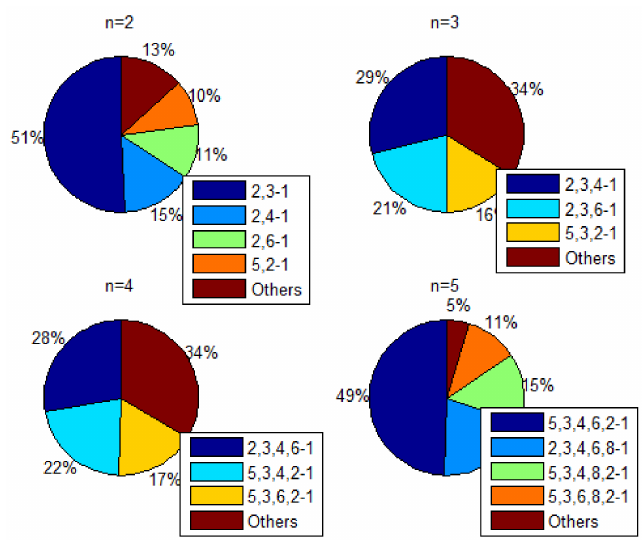
Figure 9. Fixing the consequent as 1.